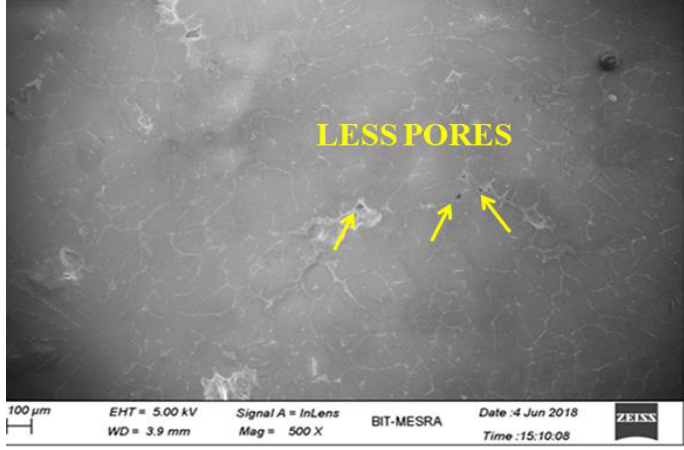
Figure 6. SEM image of sample cast by counter gravity process with 7 mm sprue diameter